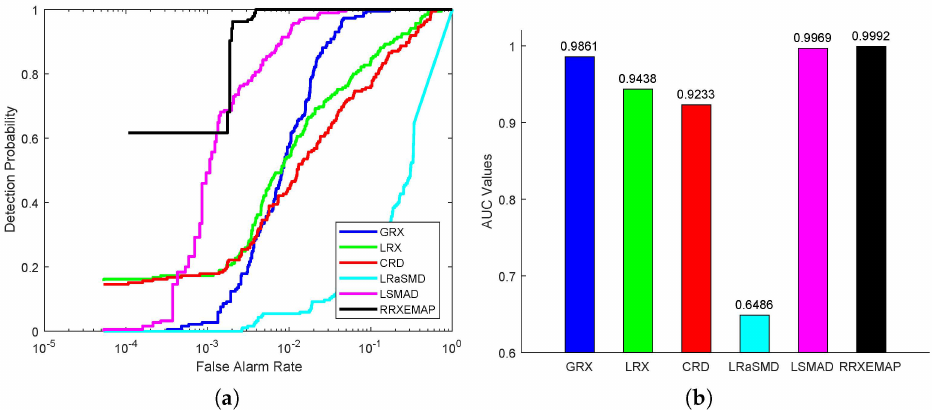
Figure 19. Detection accuracy evaluation for the Salinas-simulate dataset. ( a ) ROC curves. ( b ) AUC values.